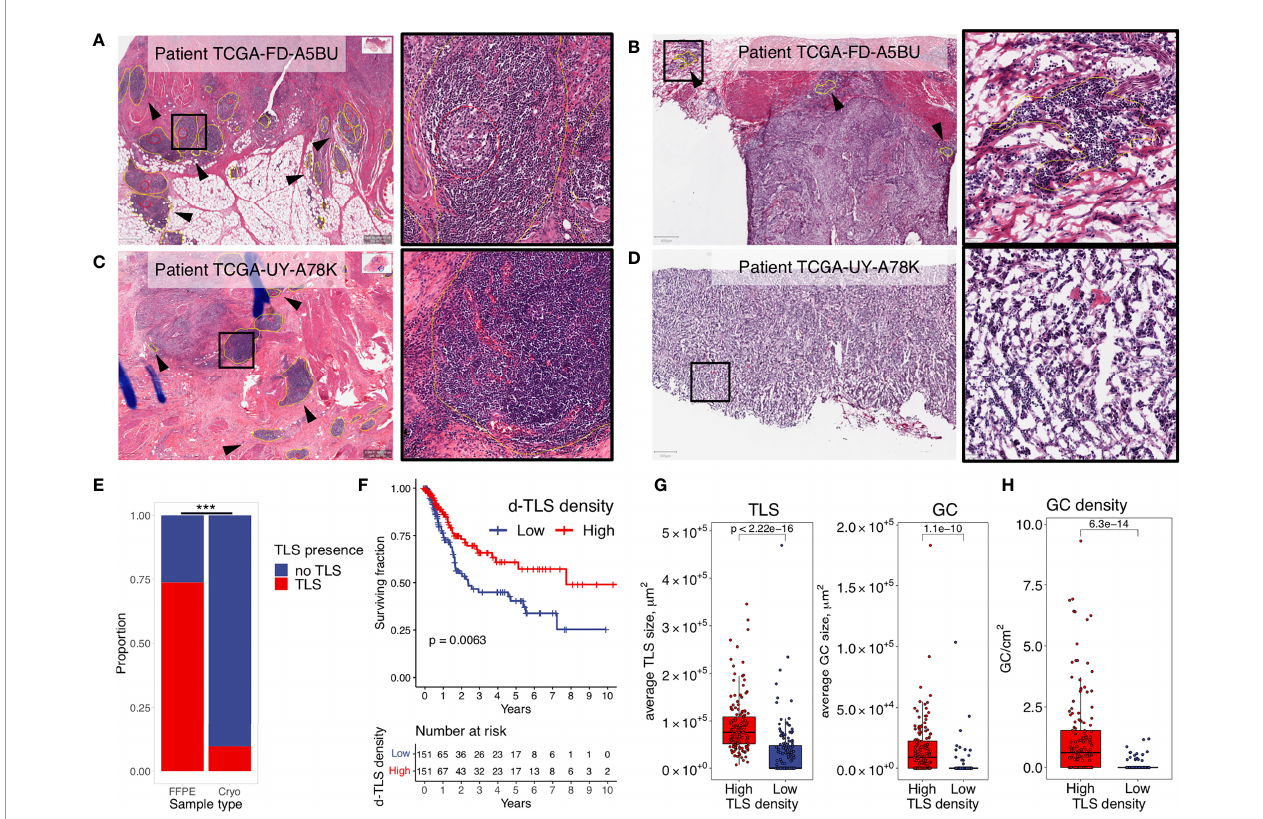
FIGURE 1 | TLS density is a signi fi cant positive prognosticator in diagnostic images of MIBC. Dense lymphocytic aggregates were assessed in histology images from diagnostic (FFPE) and matched cryopreserved (Cryo) samples of the TCGA MIBC cohort. TLS (yellow circles) and GC (red circles) were annotated using the Qupath software. Their counts and sizes were measures by ImageJ software. (A, B) Representative examples of concordant histology assessment between the two sampling methods: high d-TLS density (A) and TLS positivity in the matched cryosample (B) . (C, D) Representative examples of discordant histology assessment between the two sampling methods: high d-TLS density (C) but no TLS in the matched cryosample (D) . (E) Proportion of TLS-containing images from the diagnostic and cryopreserved samples were compared by Fisher ’ s exact test (*** p < 0.000). (F) Median d-TLS density (TLS count per tissue area) was used to de fi ne TLS-high and TLS-low patient groups for comparison of overall survival by Kaplan – Meier curve and log-rank test. (G) Average size of d-TLS and GC was calculated in each patient and compared between d-TLS density groups by two-tailed t -test. (H) GC density (count per tissue area) was compared between d-TLS density groups by two-tailed t